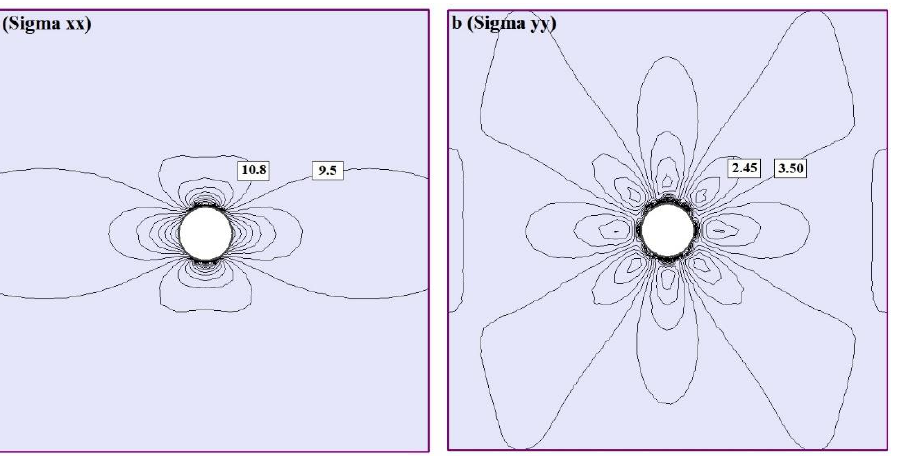
Figure 9. The isolines of stresses in the ( a ) x and ( b ) y directions.